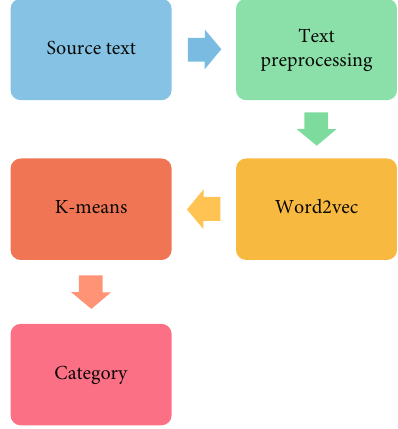
Figure 1: Speci fi c process of competency feature